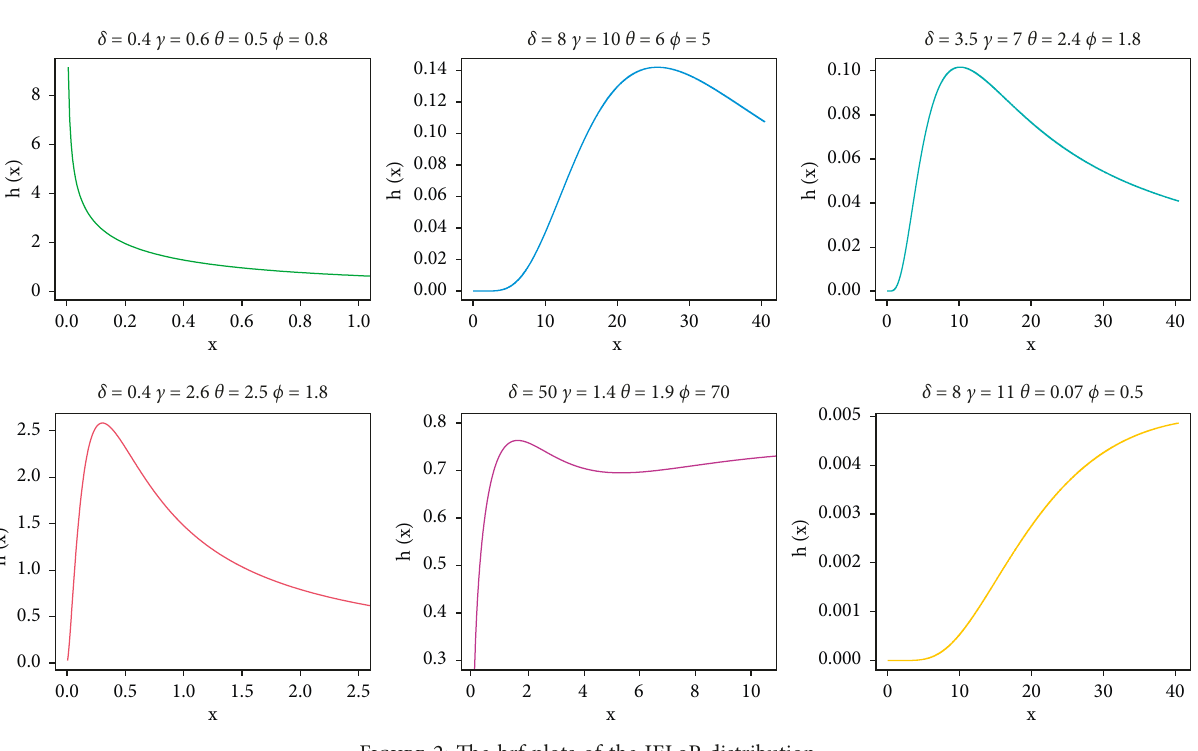
Figure 2: The hrf plots of the IELoP